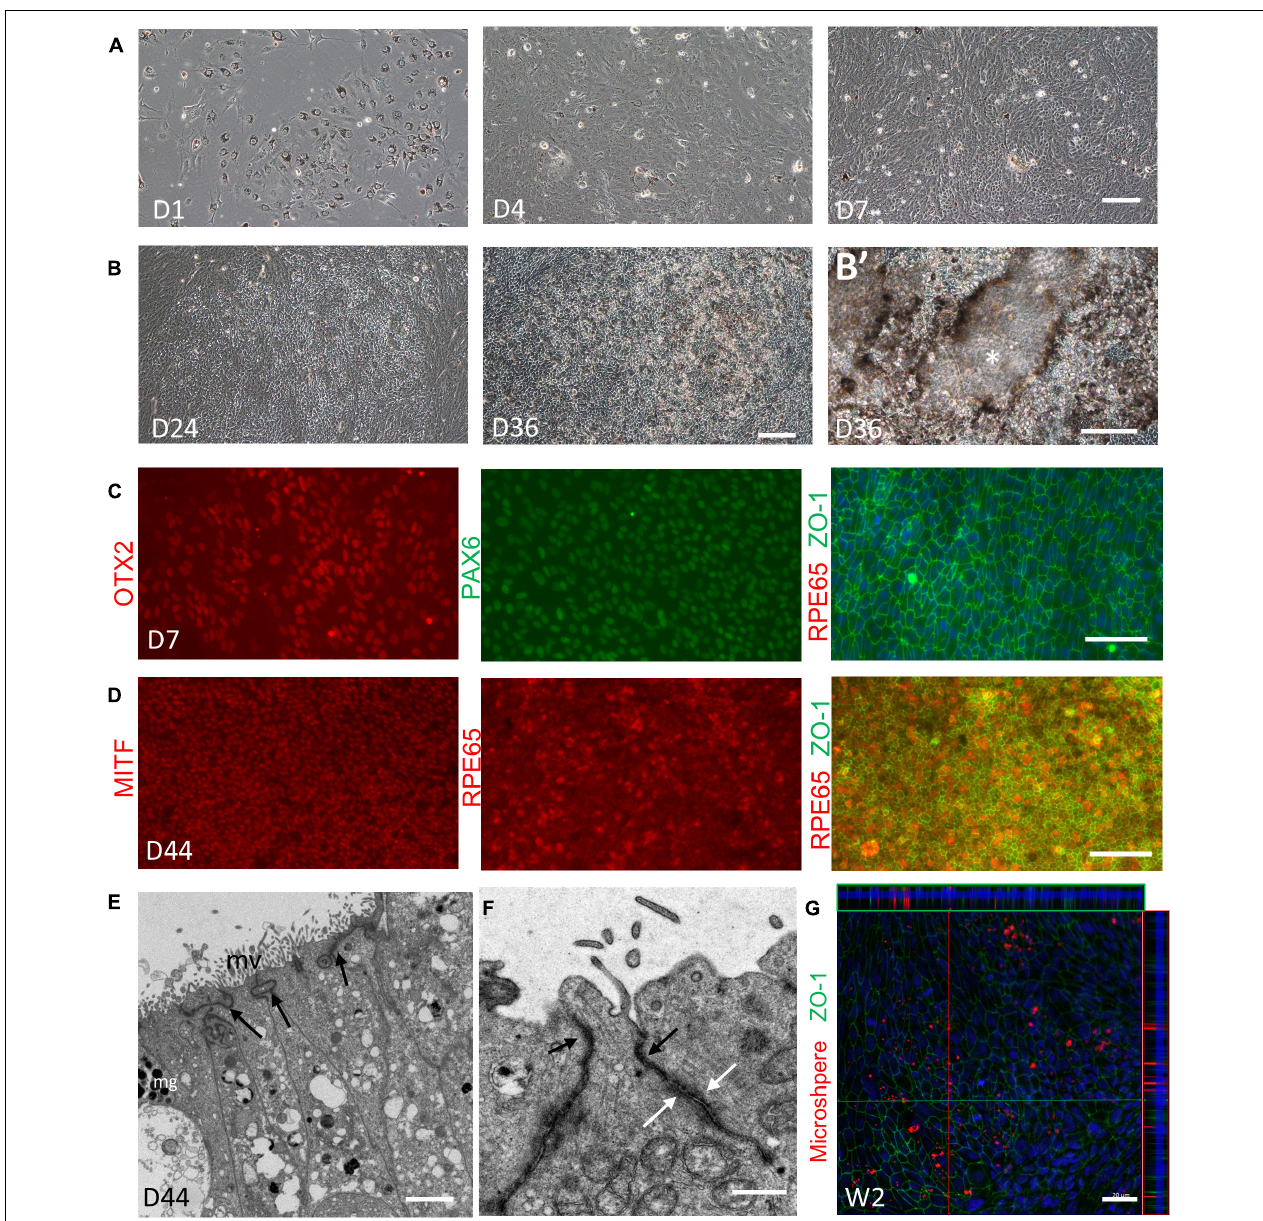
FIGURE 8 | Expansion and validation of the retina pigment epithelium (RPE). (A,B) Representative images showing the expansion and pigmentation loss of the RPE on Day 1, Day 4, and Day 7 (A) ; and the re-pigmentation on Day 24 and Day 36 (B) . (B’) Higher magnification images showing the formation of elevated domes (asterisks). (C) Expression of the naïve RPE marker OTX2 (red, left), PAX6 (green, middle) and the RPE marker ZO-1 (green, right) was shown on Day 7, while the mature RPE marker RPE65 (red, right) was not found. (D) On Day 44, RPE65 (red, left) coupled with the RPE marker MITF (red, middle) and ZO-1 (green, right) indicated the maturation of the RPE. Scale bar = 100 µ m. (E) Electron microscopy showed that on Day 44, RPE sheet has developed melanin granules (mg), microvilli (mv) and the abundant tight junctions at the apical side (indicated by black arrow). Scale bar = 2 µ m. (F) Different cell junctions of RPE were clearly shown (apical tight junctions, indicated by black arrow; desmosomes, indicated by white arrow). Scale bar = 500 nm. (G) Phagocytosis assay showed that the 2-week-old RPE sheets, labeled by ZO-1 (green), were able to phagocytose FluoroSpheres (red). Scale bar = 20 µ